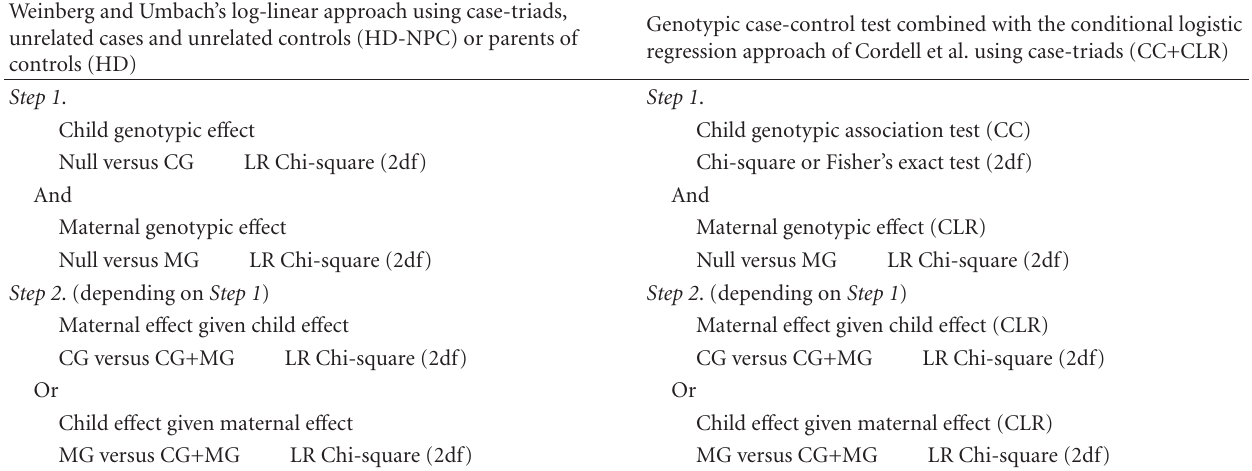
Genotypic case-control test combined with the conditional logistic regression approach of Cordell et al. using case-triads (CC+CLR)